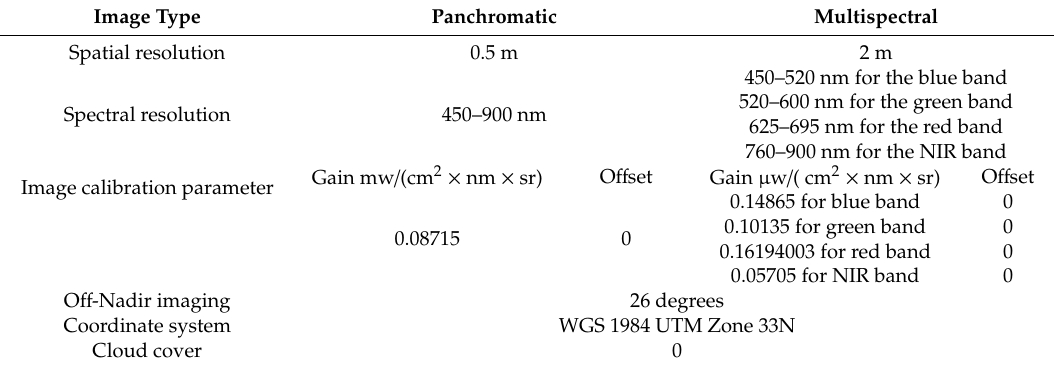
Table 1. GeoEye-1 satellite image used.